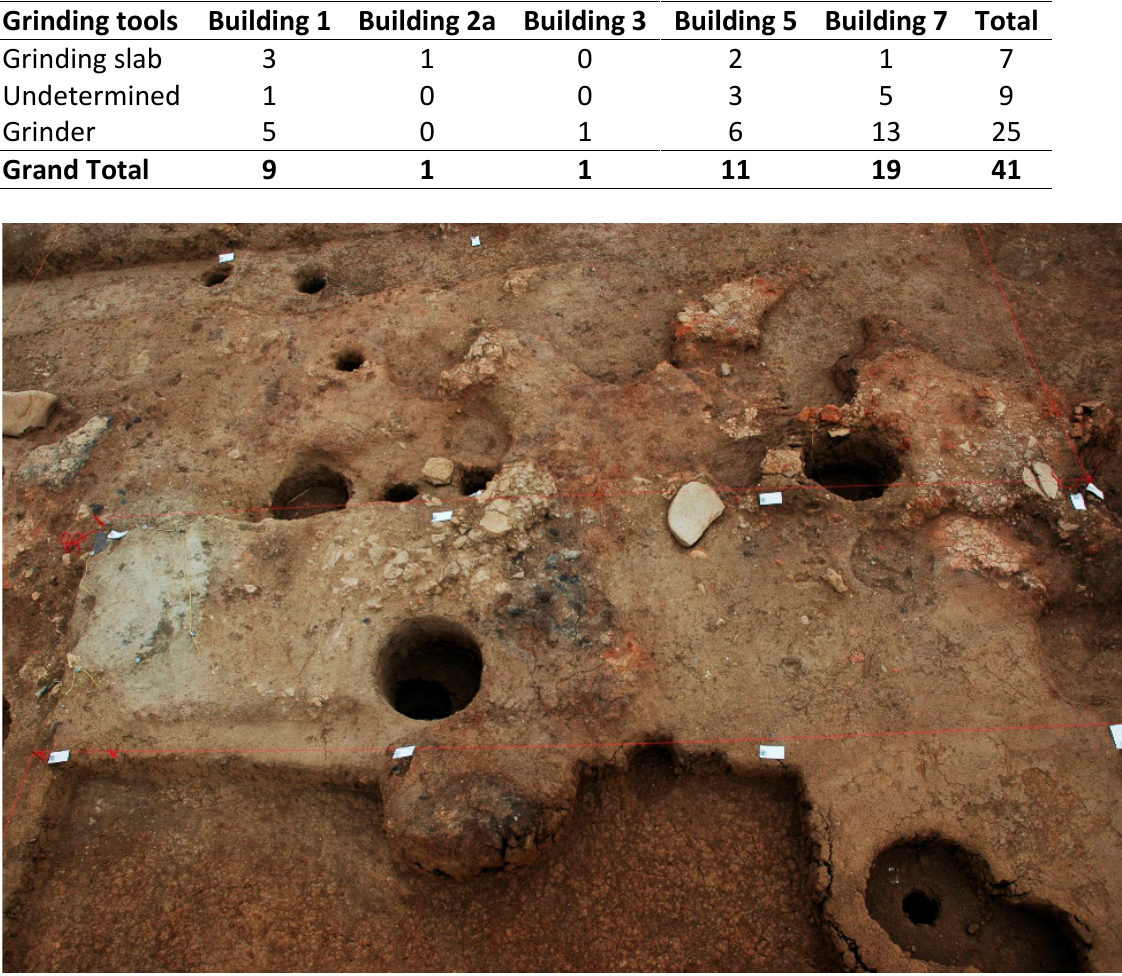
Figure 10. Grinding slab resting on the floor of Building 2a (AVGI